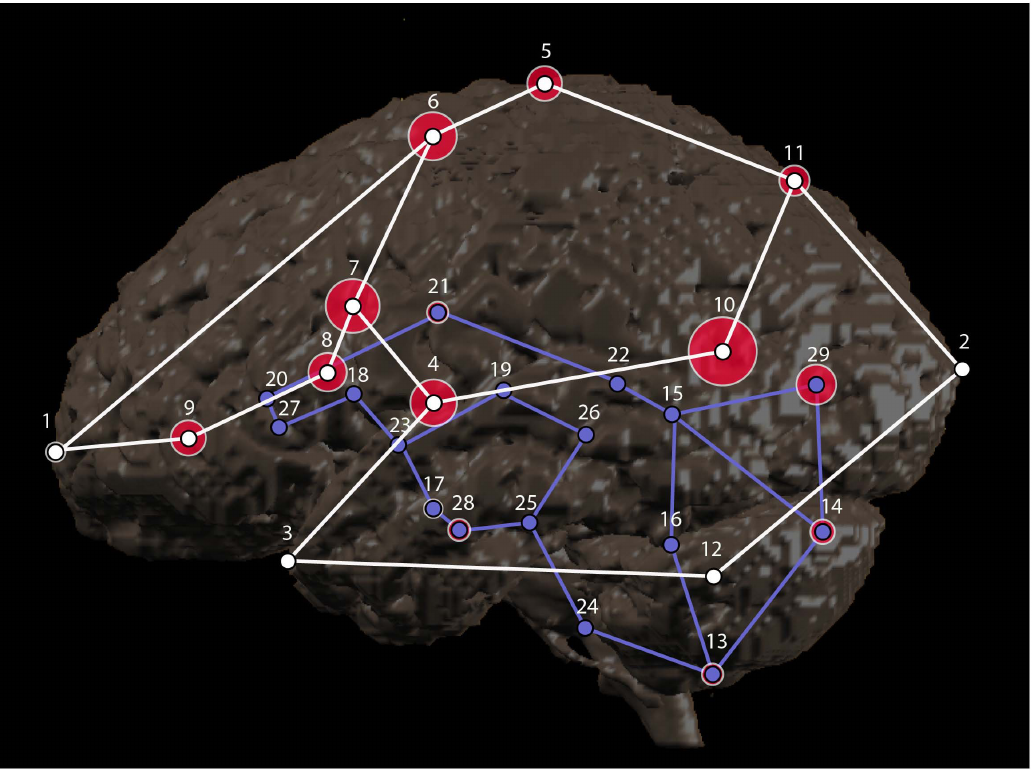
Figure 1. Landmarks and the associated error analyzed in this study. Left lateral view of a 3D reconstruction of the brain (anterior is to the left). Projected positions of landmarks are shown with numbers corresponding to Table 2. Cortical surface landmarks are white with white wireframe; subcortical landmarks are purple with purple wireframe. The size of the pink ellipses around each landmark indicate the magnitude of average precision (error) at anatomic scale. Landmarks for which no ellipse is visible had average error less than the 1.5 mm radius of the landmark marker. Note that the greatest magnitudes of error were associated with cortical surface landmarks. doi:10.1371/journal.pone.0086005.g001 (15%) had an average inter-observer error greater than 3 mm. sulcus with the superior frontal sulcus and increased by 0.1 mm for Average intra-observer error decreased for eleven out of the the inferior horn of the lateral ventricle. Inter-observer error thirteen landmarks using the modified protocols. Intra-observer decreased for every landmark but two – pre-central s./inferior error increased by 0.3 mm for the intersection of the precentral